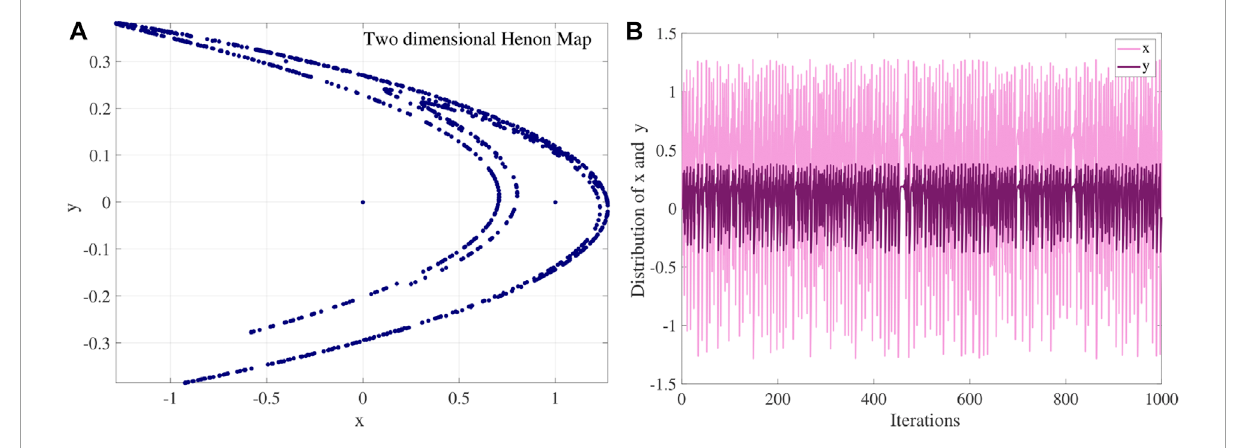
FIGURE 3 Henon map (A) Henon attractor, and (B) x , y distributions.